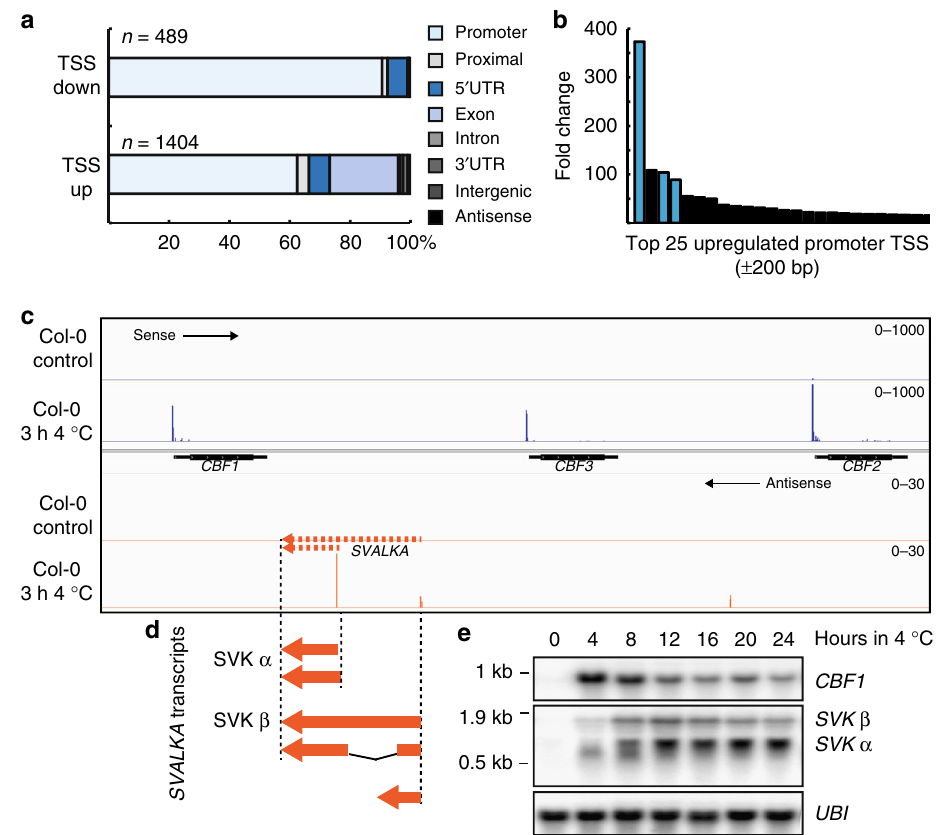
Fig. 1 Transcription Start Site (TSS) sequencing in Col-0 after 3 h of exposure to 4 °C identi fi ed the long non-coding RNA, SVALKA . a Differentially expressed TSS after cold exposure in Col-0. A total of 1893 TSS changed their expression signi fi cantly ( p < 0.05). Of these, 489 were down-regulated while 1404 were up-regulated. The TSS were classi fi ed according to their position relative to gene bodies . The majority of differentially expressed TSS were found in or around promoters. b Activity of up-regulated promoters after cold exposure identities the CBF genes (indicated in blue bars) as highly up- regulated. Graph represents the fold change of the top 25 up-regulated promoters in Col-0 after cold exposure. c Screenshot of the CBF genomic region and the identi fi ed TSS. The upper panel shows the sense TSS-seq reads direction (blue) and clear TSS can be found for the three CBF genes. The lower panel shows the TSS-seq reads in antisense direction (orange) where a group of cold-induced TSS was identi fi ed in the intergenic region between CBF1 and CBF3 . d Summary of 3 ′ - and 5 ′ -RACE of SVALKA . Two clusters of capped TSS were found for SVALKA , a distal TSS centered around 2360 bp and a proximal TSS centered around 1386 bp in respect to the translation start of CBF1 . A cluster of polyadenylation sites were found 846 – 897 bp in respect to the translation start of CBF1 . The plethora of SVALKA transcripts includes a spliced isoform with a splice site from 1386 to 2113 bp in respect to the translation start of CBF1 . e RNA levels of CBF1 and SVALKA during a time course of cold exposure of Col-0. While CBF1 transiently is upregulated early in the cold response, SVALKA responds later and its expression is anti-correlated to sense CBF1 . UBI is used as a loading control. Experiments were done with three biological replicates showing similar results. Uncropped blots can be found in the Source Data fi